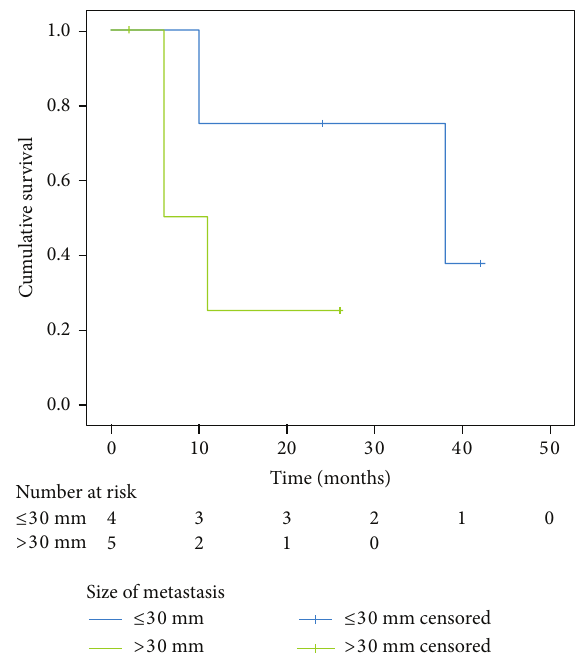
Figure3:Kaplan-Meiersurvivalcurveofsubgroupsofpatientswith small ( ≤ 3 cm) and big ( > 3cm) tumors; 𝑃 = 0, 180